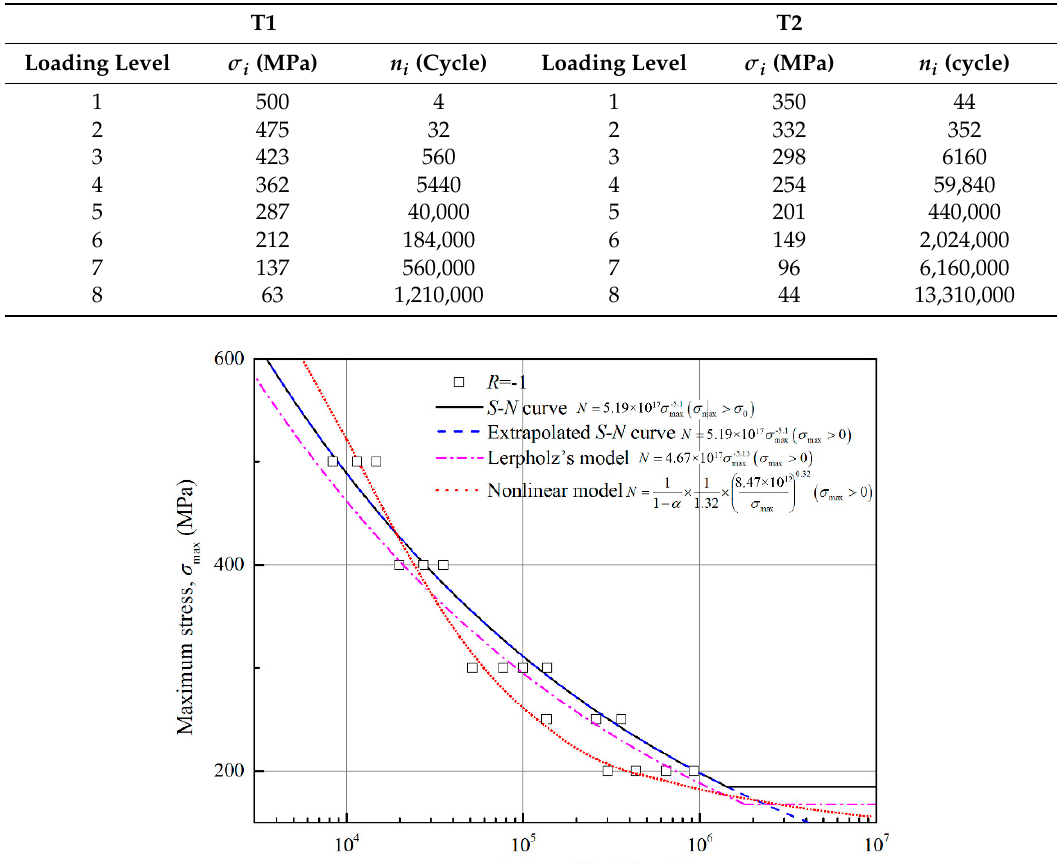
Table 1. The experimental data of 41Cr4 steel [27].